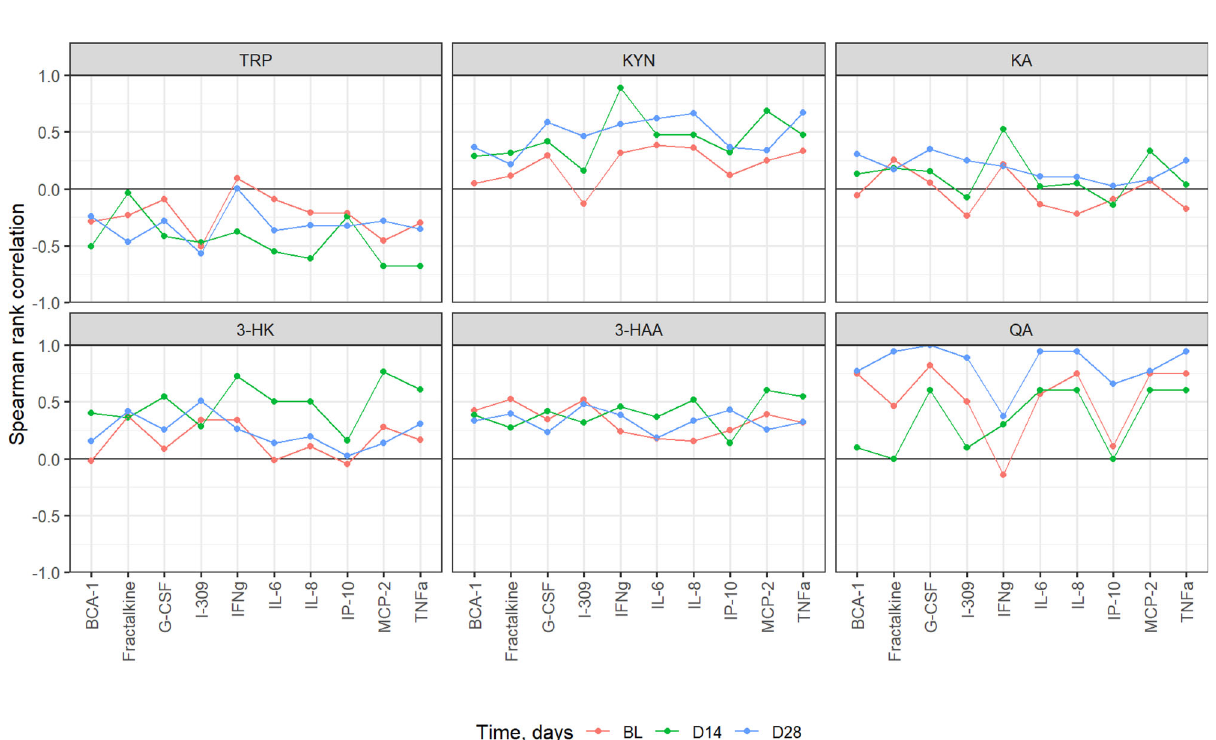
Fig. 5 Spearman ranked correlations between peak cytokine concentrations and tryptophan metabolites measured across baseline, D14, and D28. BL baseline, TRP Tryptophan, KYN Kynurenine, KA Kynurenic acid, 3-HK 3-Hydroxykynurenine, 3-HAA 3-Hydroxyanthranilic acid, QA Quinolinic acid. Spearman ranked correlations were done utilizing all available participants ( n = 15).